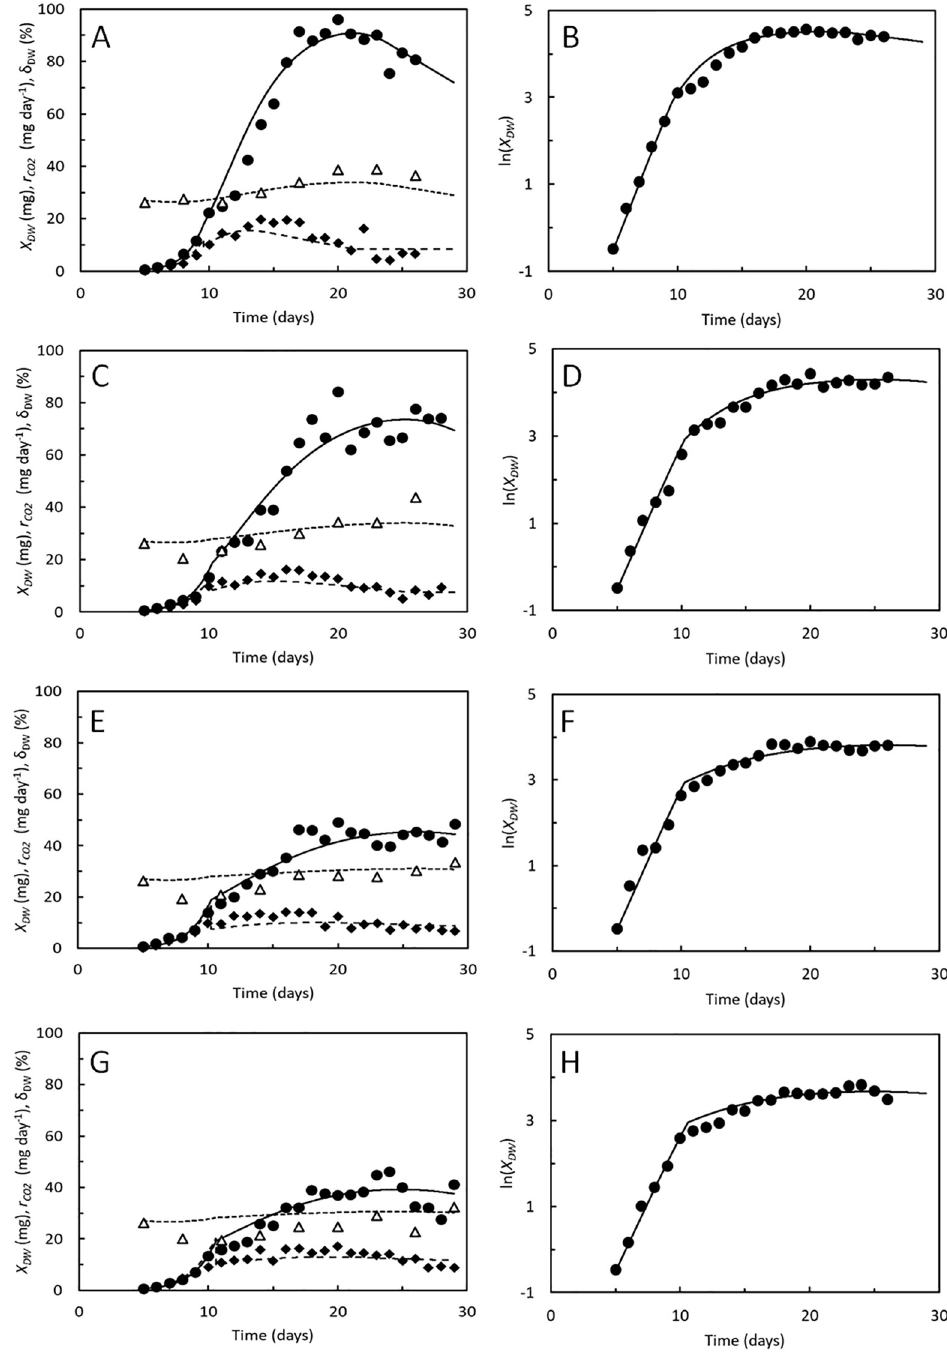
Fig 5. Hermetia illucens. A, C, E, G. Dry weight, X DW ( ● ), dry weight fraction of biomass, δ DW ( △ ), and CO 2 production rate, r CO2 ( ◆ ) of BSF larvae reared on chicken feed (A), 75% chicken feed and 25% degassed sludge (B), 50% chicken feed and 50% degassed sludge (D), and 25% chicken feed and 75% degassed sludge (G). Logarithmic transformed dry weight ( ● ) of the BSF larvae. Data points from [9]. Curves predicted by the growth model. Parameters shown in Table 2.